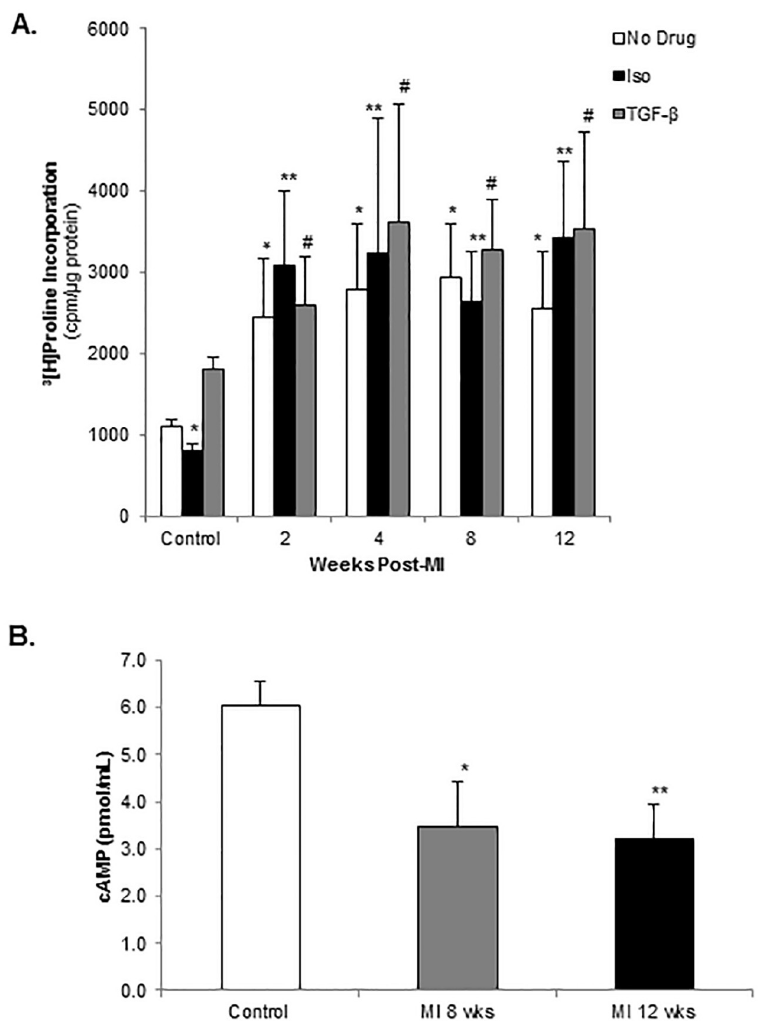
Fig 4. Collagen synthesis and post-MI uncoupling of cardiac fibroblast β -adrenergic signaling. A. Collagen synthesis in control and post-MI CF under basal conditions and following TGF- β or β -agonist (Isoproterenol) stimulation. � p < 0.02 vs. control + No Drug, �� p < 0.005 vs. control + Iso, #p < 0.01 vs. control + TGF- β ; n = 3–9 in each group. B. Intracellular cAMP levels in CF isolated 8 and 12 weeks post-MI vs. control. � p = 0.05 vs. control, �� p < 0.02 vs. control; n = 3 in each